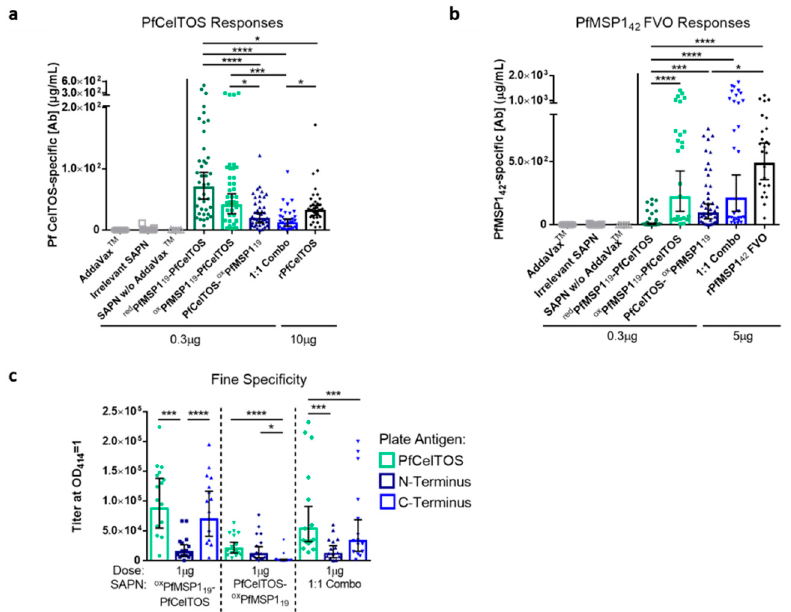
Figure 3. Antigen localization and epitope density on SAPN influences immunogenicity and anti ‐ body fine specificity. ( a – c ) BALB/c mice were immunized I.M. 3 times at a 3 ‐ week interval with